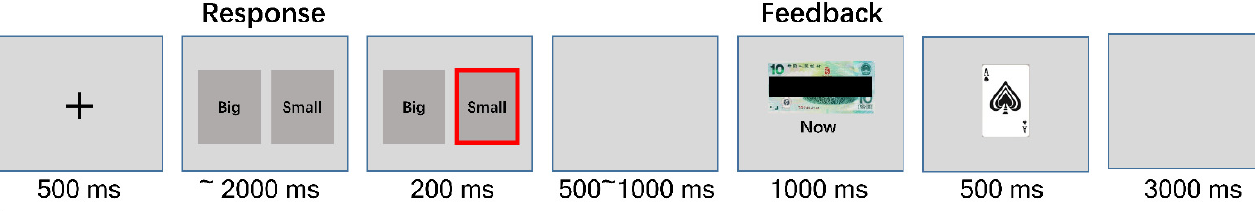
Figure 1. Shows that the participant was required to gamble the two porkers (“Big” or “Small”). The chosen option would be highlighted by a thick red border. All kinds of outcome feedback were presented randomly over the four conditions (now/ordinary; now/scarcity; future/ordinary; future/scarcity). In this example, the participant chose “Small” and gained an Olympic commemorative banknote “now”, then the chosen poker was presented. EEG was only for the phase of feedback. In the formal experiment, the black rectangle on the banknote was not shown in the phase of feedback.